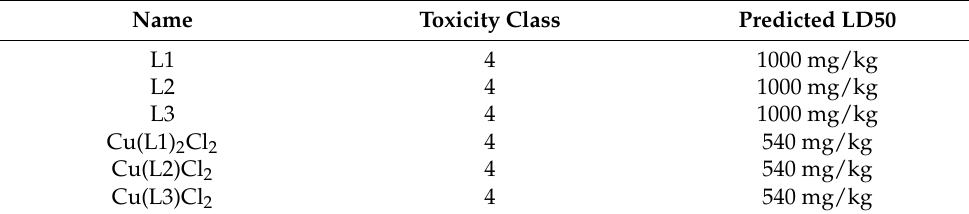
Table 5. Toxicity prediction results.